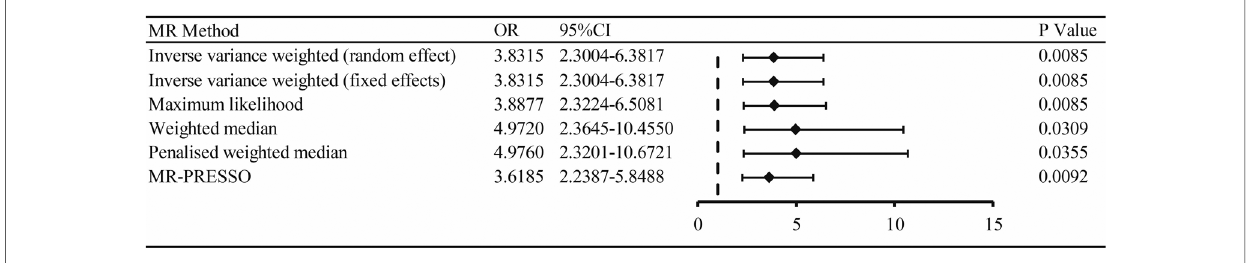
FIGURE 2 The association of hypertension with ED outcomes by MR analysis through different methods (random effect and fi xed effects inverse variance weighted method, maximum likelihood, weighted median, penalized weighted median, MR-PRESSO). OR: odds ratio; CI: con fi dence